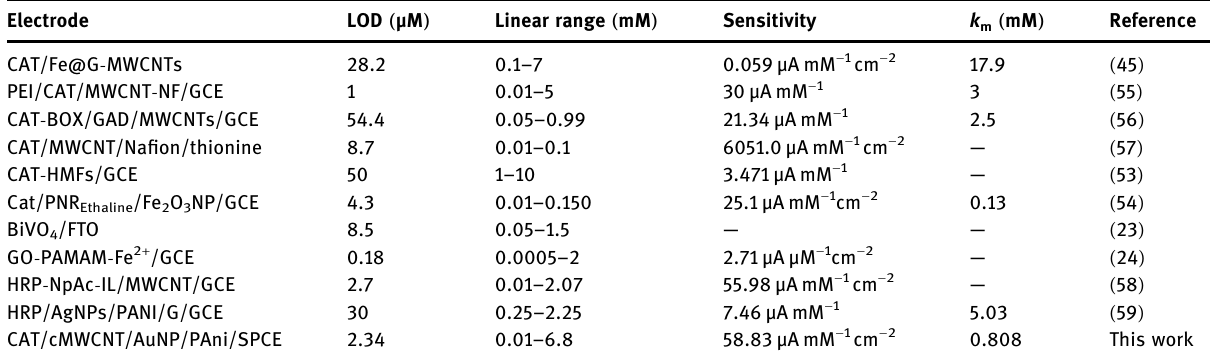
Table 1: Comparison of electroanalytical parameters of electrochemical ( bio ) sensors for H 2 O 2 detection Electrode